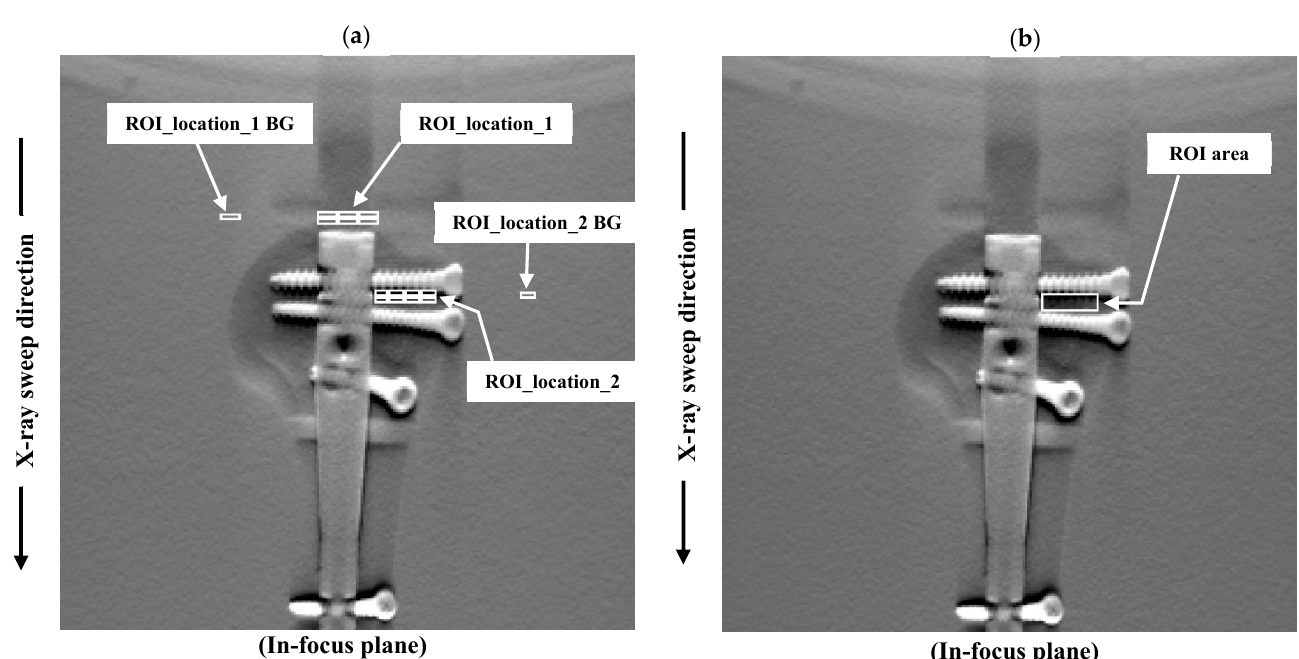
Figure 2. Assessment of improvements in image quality using the artifact index (AI), a statistical model with a Gumbel distribution of the selected features. The in-focus plane images shows the ( a ) artifact and background areas of the AI and ( b ) measurements and high-frequency artifact with prosthetic areas of the Gumbel analysis.